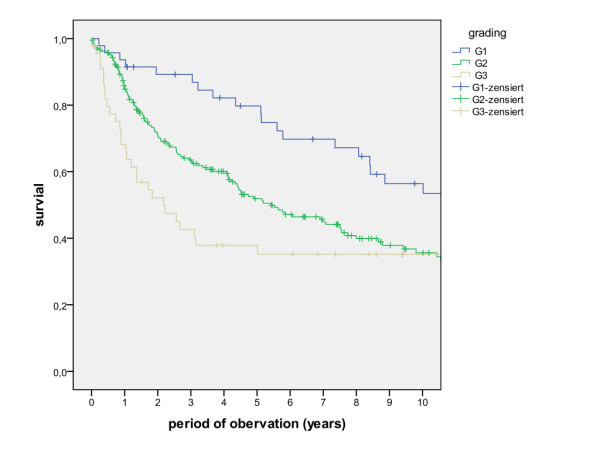
Survival of patients with different tumour grading (log rank p = 0.004).